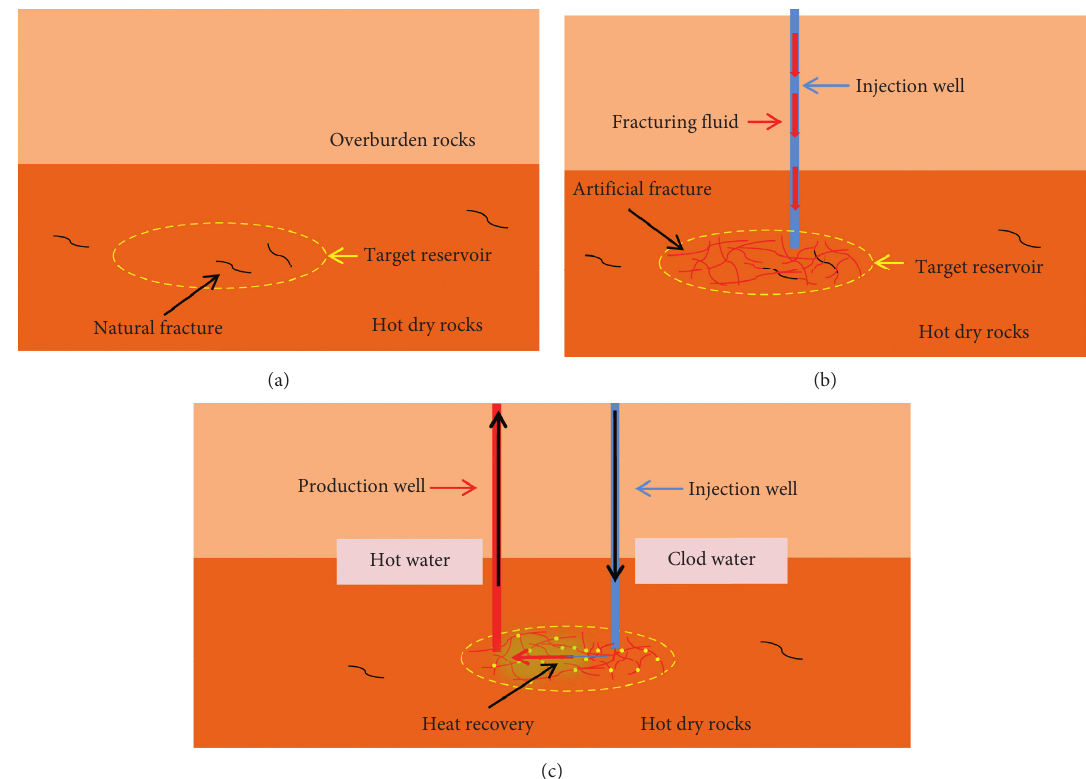
Figure 1: The EGS of HDR geothermal exploitation. (a) Natural HDR. (b) Hydrofracturing. (c) Heat